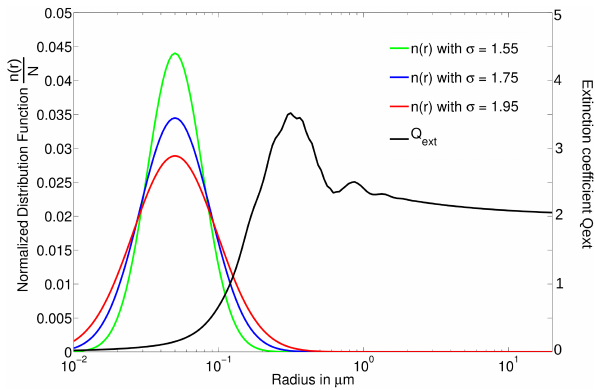
Fig. 2. Extinction efficiency as a function or radius overlaid on the three size distributions corresponding to the same geometric stan- dard deviations as in Fig. 1 and the same median radius of 0.045µm and a refractive index of 1.55–0.1 i .